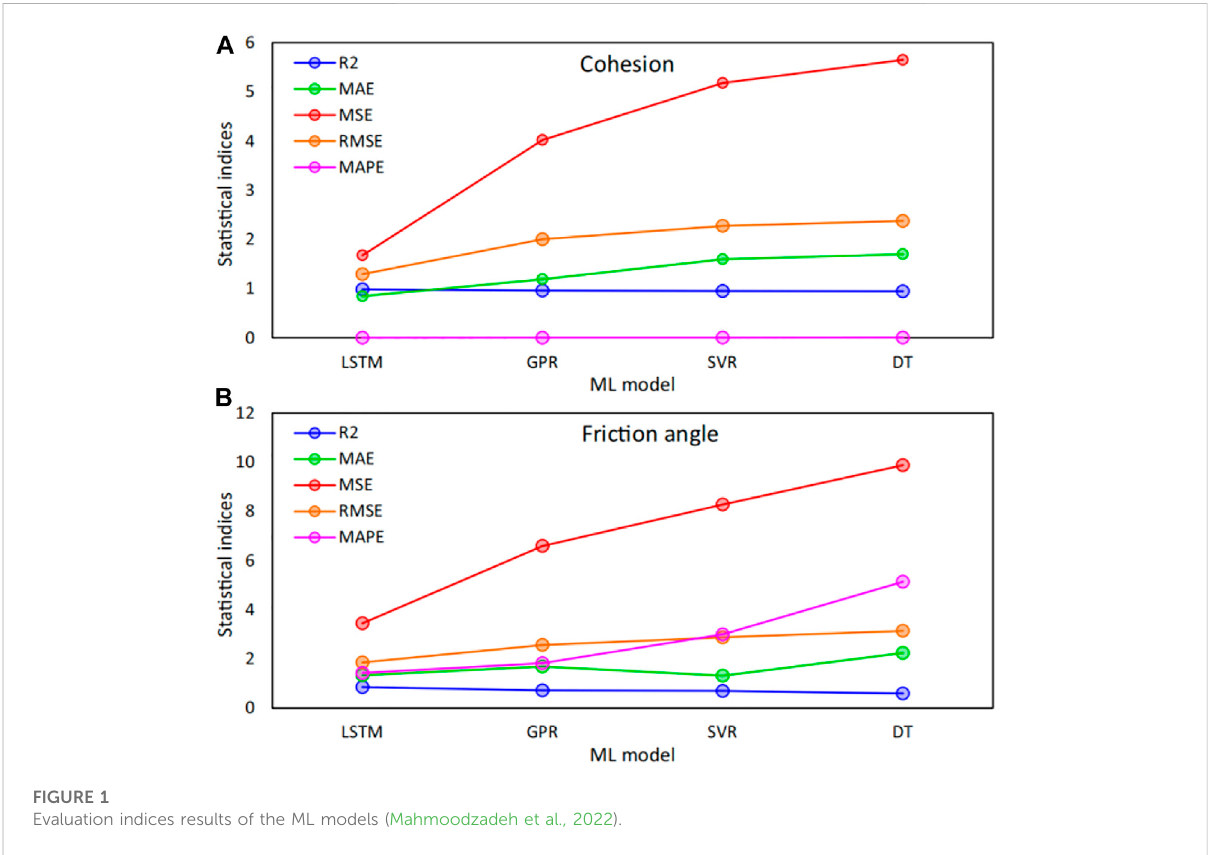
FIGURE 1 Evaluation indices results of the ML models (Mahmoodzadeh et al., 2022).